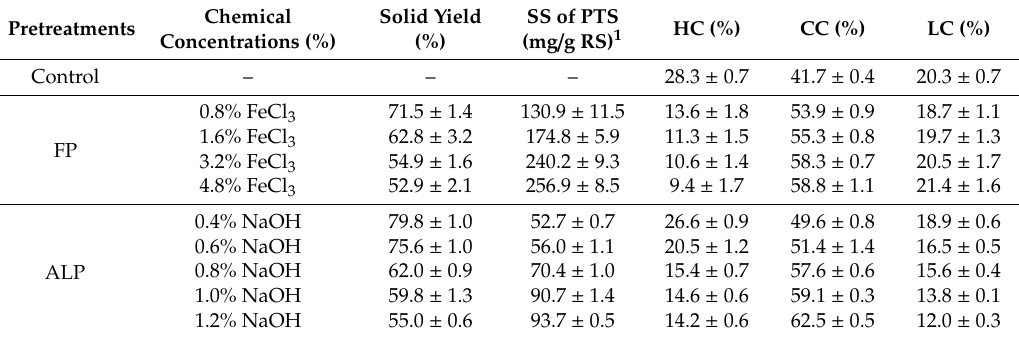
Table 1. Solid yield and chemical composition after di ff erent